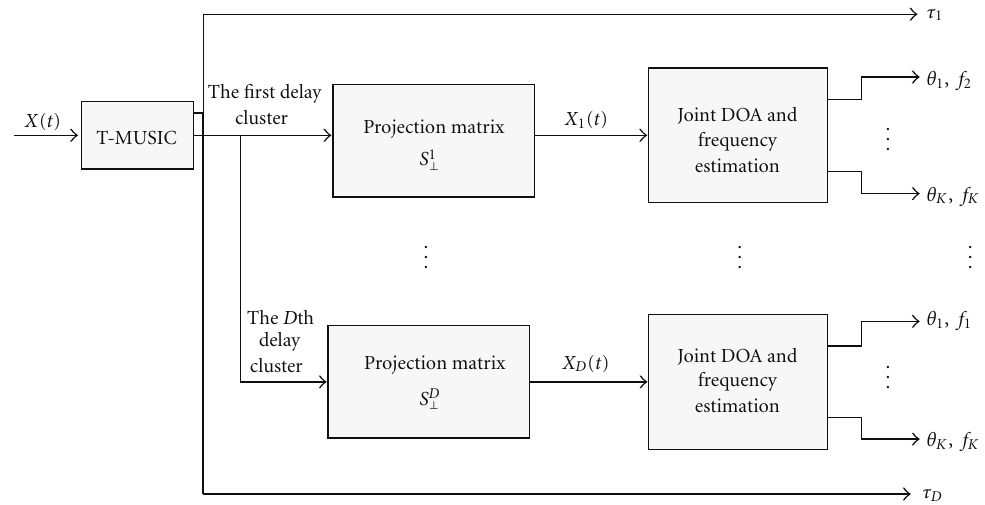
Figure 1: The flow chart of the our modified MUSIC